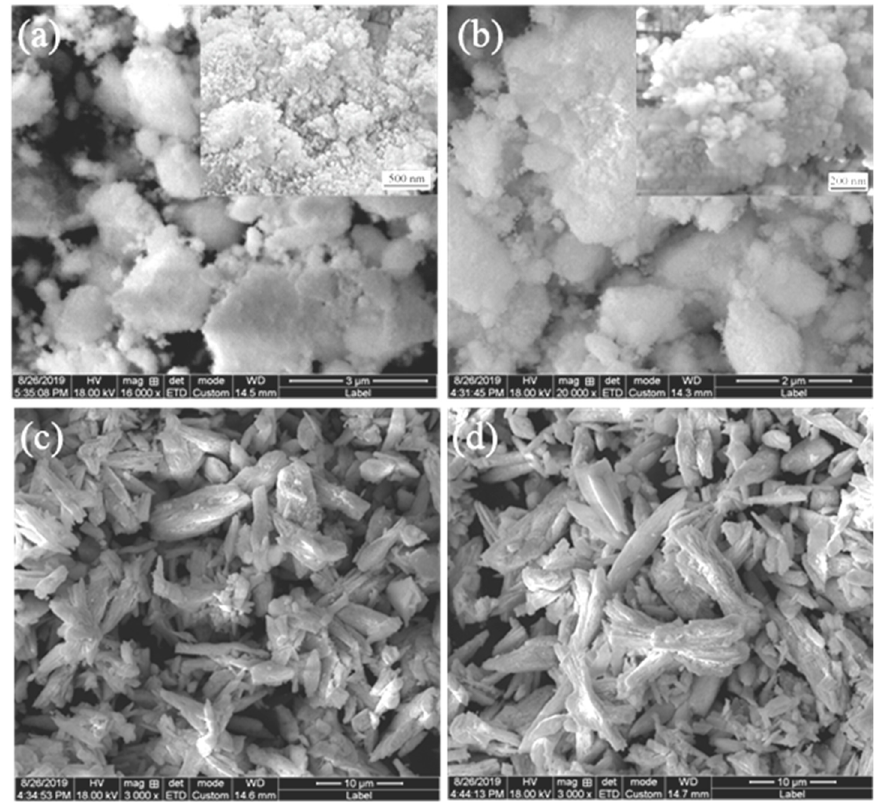
Figure 1. Different sizes of CeO 2 : ( a ) 30nm; ( b ) 50nm; ( c ) 1 μ m; ( d ) 2–4 μ m.